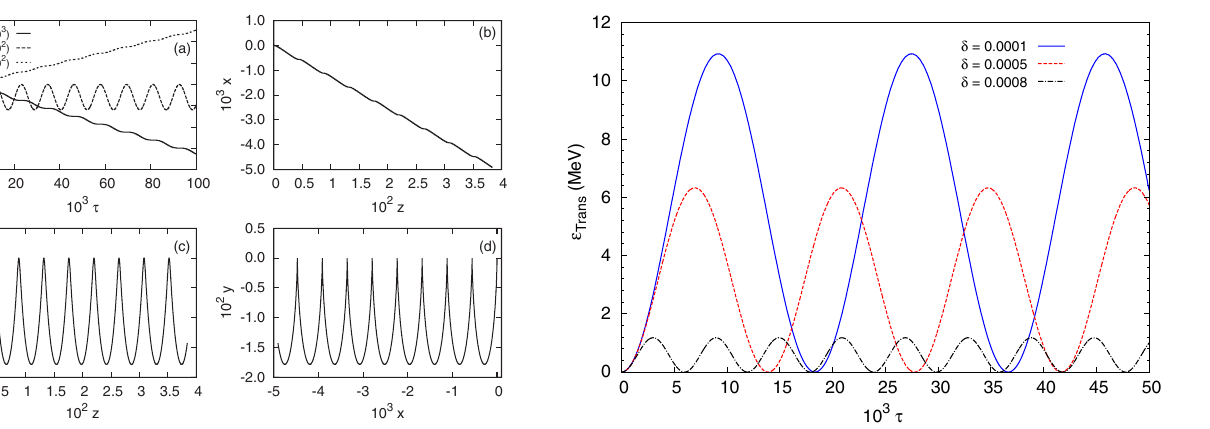
FIG. 6. Temporal evolution of the transverse kinetic energy for various values of detuning parameter (cid:5) . The resulting phase modulation factor would be (cid:3) þ (cid:5) with (cid:3) ¼ 0 : 50 .